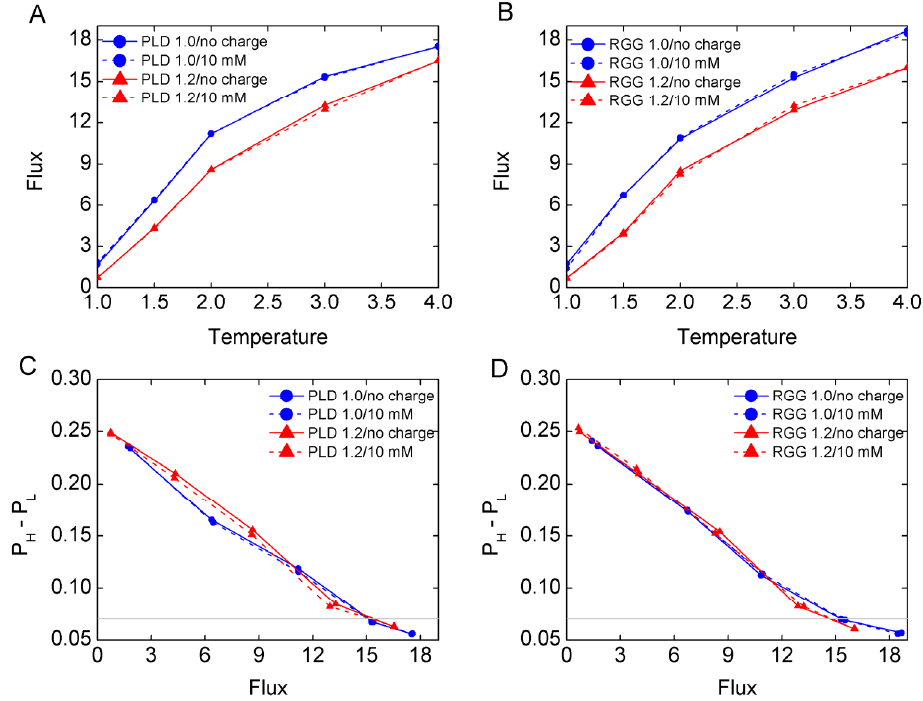
Figure 6. The flux on the boundary line. ( A ) The flux of PLD 1.0 and PLD 1.2 in different solvents changes with temperature. ( B ) The flux of RGG 1.0 and RGG 1.2 in different solvents changes with temperature. ( C ) P H − P L of PLD 1.0 and PLD 1.2 in different solvents change with flux. ( D ) P H − P L of RGG 1.0 and RGG 1.2 in different solvents change with flux. The fluxes are calculated by averaging the last 1000 τ simulation data, and the boundary line is |z| = 25 nm. The gray line is P H − P L = 0.07.